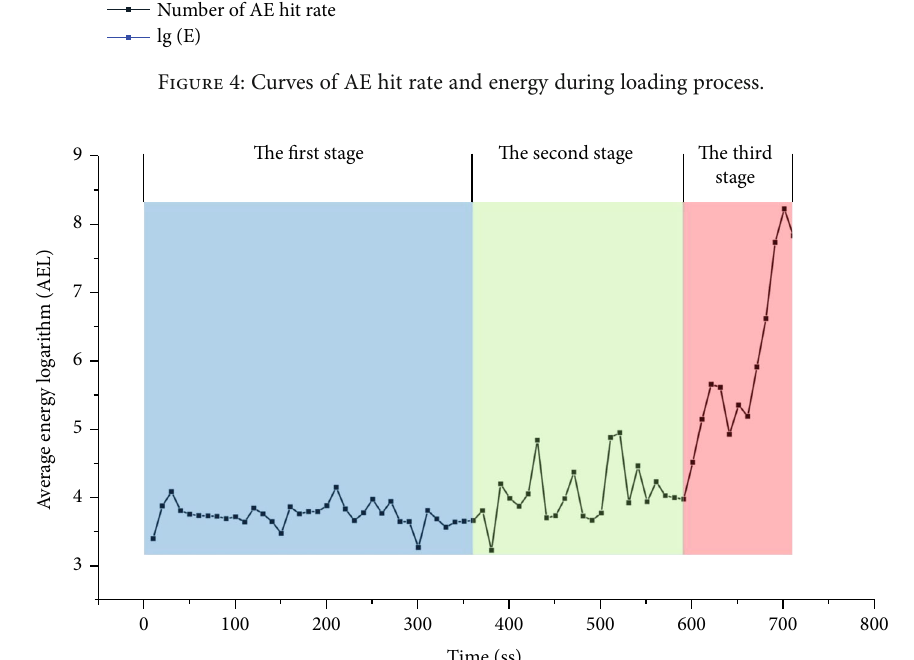
Figure 5: Change curve of AEL during the experiment